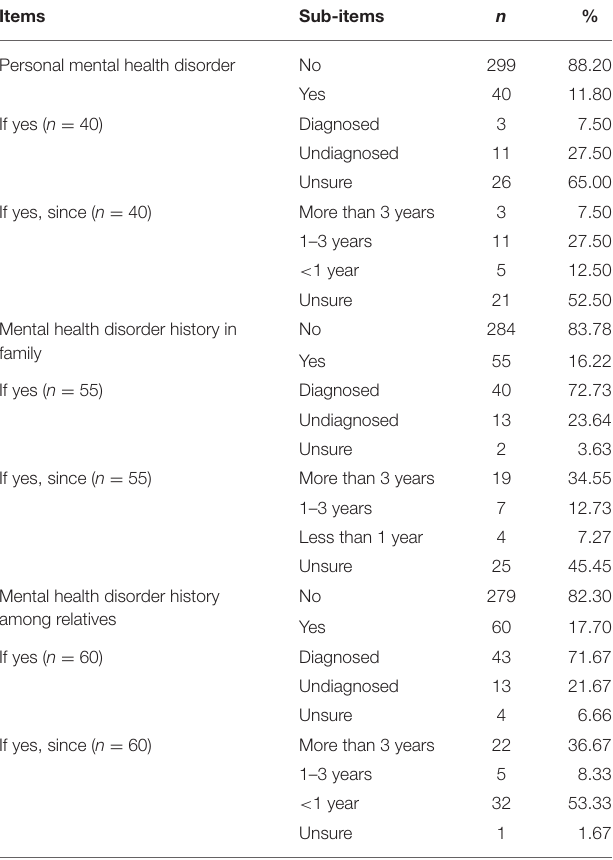
TABLE 4 | Personal history of mental health disorders of Saudi university students ( N =